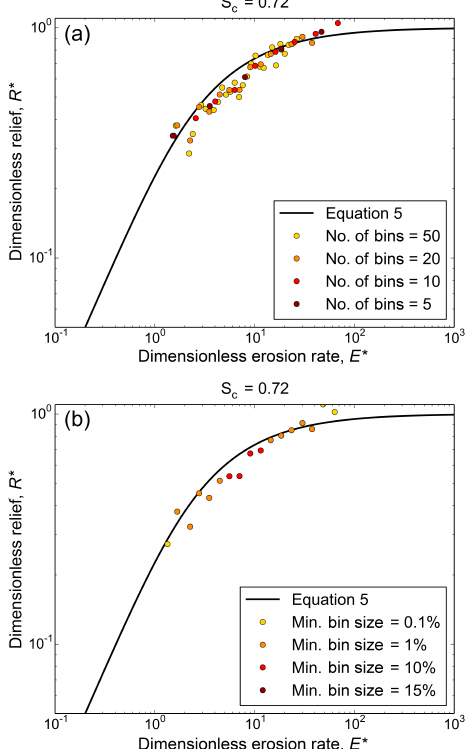
Figure 10. Comparison of the influence of binning parameters on the interpretation of E ∗ R ∗ data for Cascade Ridge. (a) Varying the number of bins used, equivalent to the bin width in E ∗ space. As the number of bins reduces it becomes harder to identify patterns in the data, and as the number of bins increases, the number of data points in each bin reduces, thereby reducing the power of the binning tech- nique. (b) Varying the minimum number of data points required in a basin. As this value increases, fewer points are preserved, which compresses the range of the data and can obscure the observation of an erosional gradient. Too small a threshold can result in bins con- taining very few values which do not represent the landscape as a